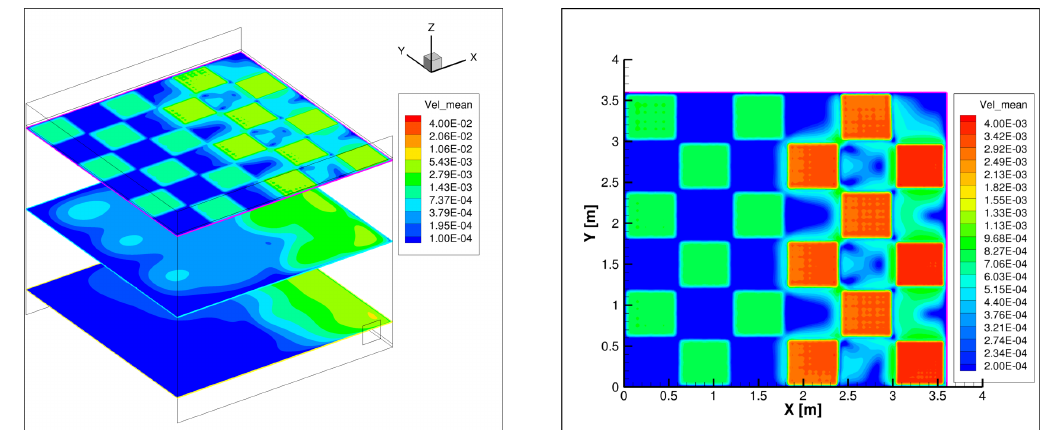
Figure 10. Velocity contour: three horizontal planes (left); the top plane below the ceiling (right) for the chessboard distribution in configuration Outlet 2.